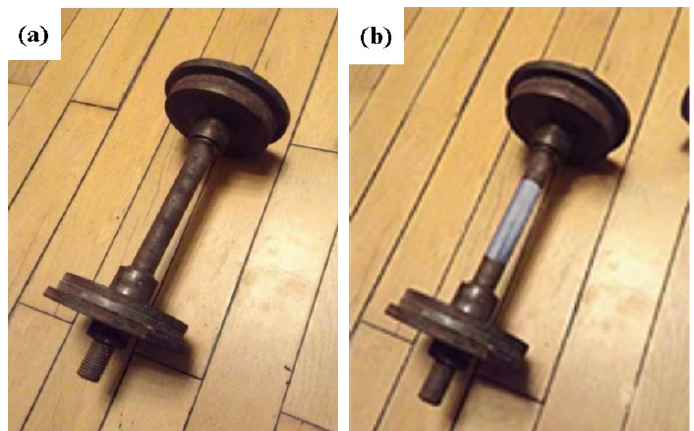
Figure 11. Images of the B20-1-A ( a ) and B20-1-B ( b ) dumbbells.